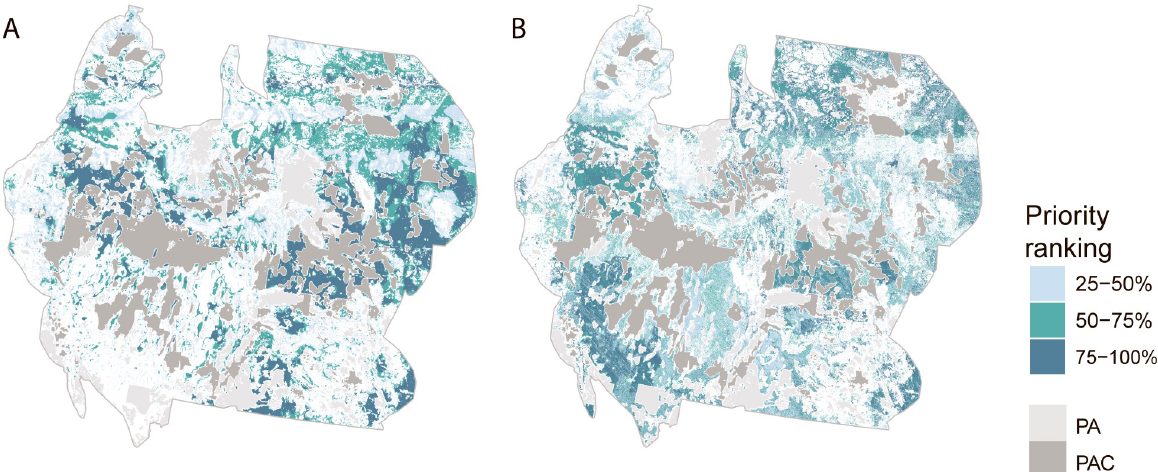
Fig 3. Conservation priority ranking of areas outside the existing protected area estate (PAs–light grey) and Priority Areas for Sage Grouse Conservation (PACs–dark grey) across the western US, Albers equal area projection. Ranking was based on biological criteria and generated by the decision support tool Z ONATION across a suite of 81 sagebrush-associated species, under two objective functions and accounting for complementarity (A) the Prioritize richness outside PACs scenario gives a higher ranking to locations that contain greater numbers of species, whereas (B) the Prioritize rarity outside PACs gives a higher ranking to locations containing rare or small-ranged